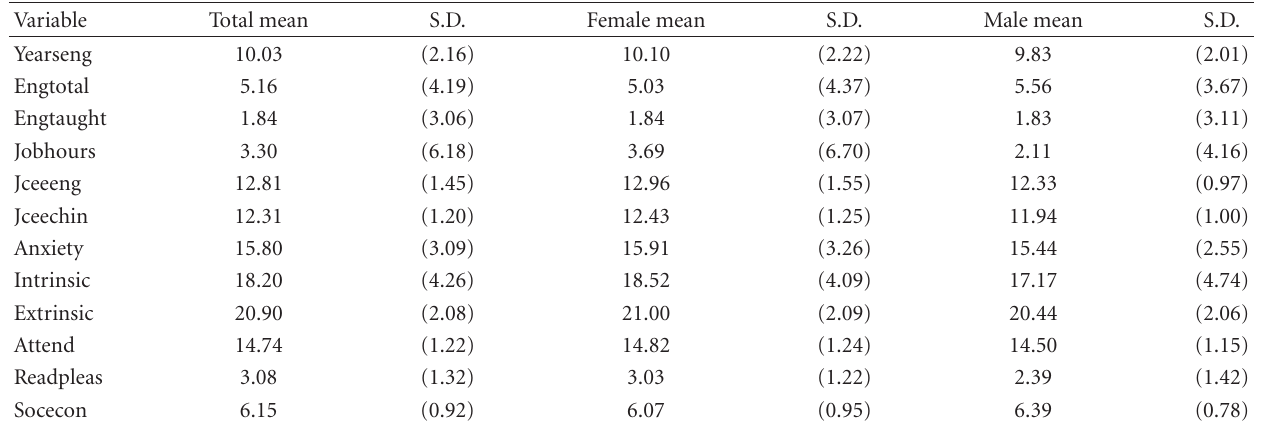
Table 2: Explanatory variable means and standard